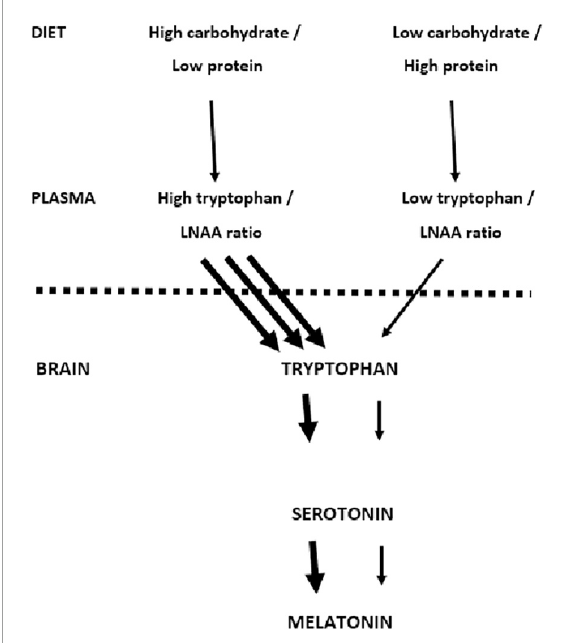
FIGURE1 Dietary carbohydrate and the uptake of tryptophan by the brain. The mechanism proposed by Fernstrom and Wurtman (18) is outlined. The suggestion is that a high carbohydrate meal increases the uptake of tryptophan by the brain increasing the synthesis of serotonin and